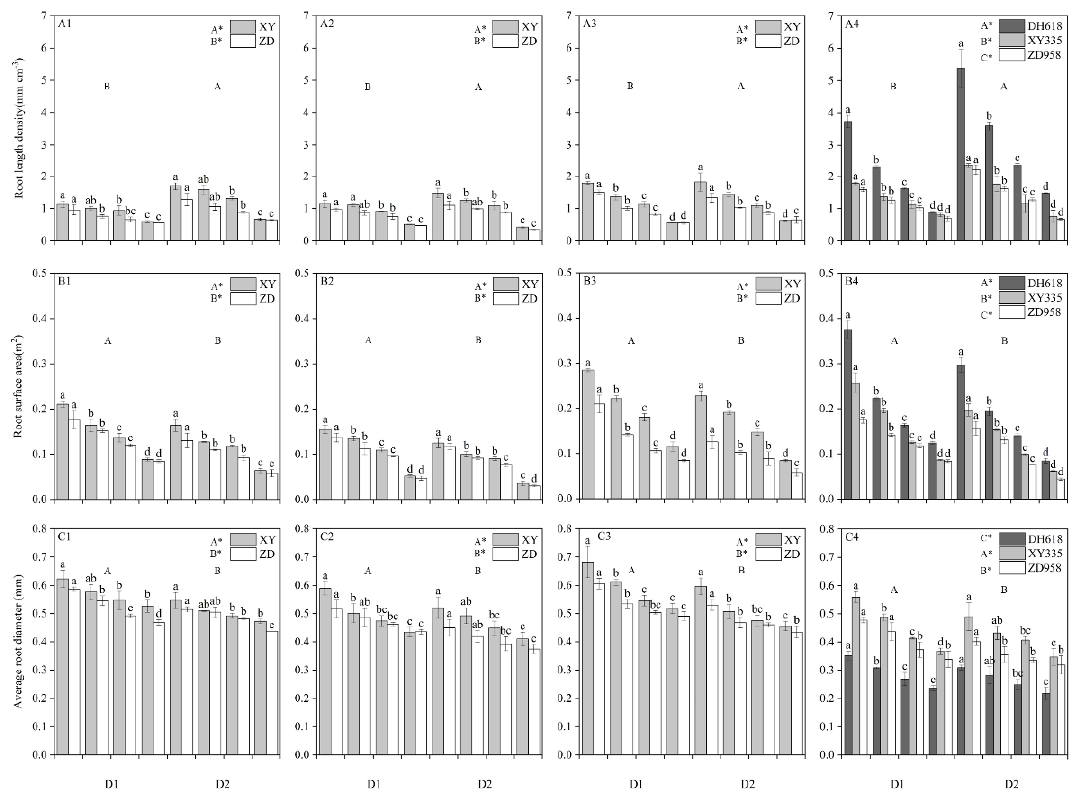
Figure 9. Maize root length density (RLD, mm cm −3 ), root surface area (RSA, m 2 ) and average root diameter (ARD, mm) under different shading levels and planting densities. The bars represented the error standard ( n = 3). Analysis of variance was used to compare the differences of CK, S1, S2 and S3 among different cultivars under D1 or D2 density. No shared lowercase letters indicate significant differences between shading levels at p < 0.05. No shared capital letters indicate significant differences between planting densities at p < 0.05. No shared capital letters and * indicate significant differences between planting cultivars at p < 0.05. ( A1 , B1 , C1 ): 2018 Yinchuan; ( A2 , B2 , C2 ): 2019 Yinchuan; ( A3 , B3 , C3 ): 2018 Qitai; ( A4 , B4 , C4 ): 2019